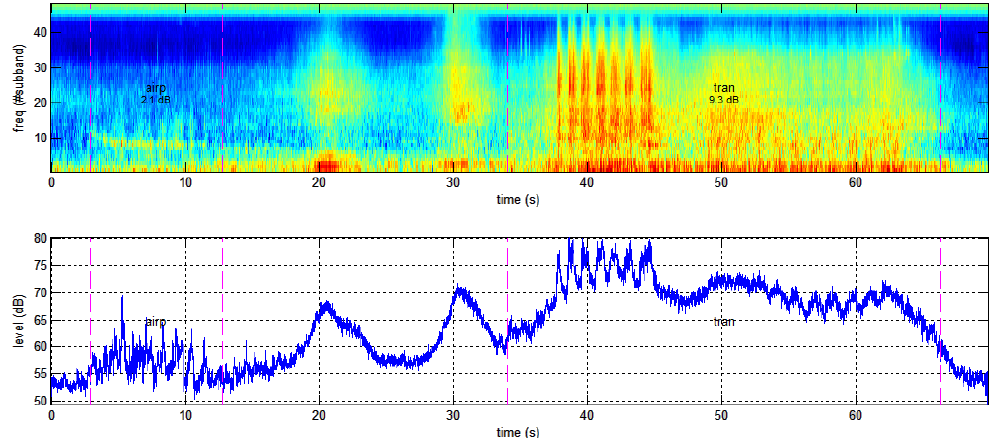
Figure A2. Examples of a mid-salient ANE (airplane, with SNR = 2.1 dB) and a highly-salient ANE (train, with SNR = 9.3 dB) in the urban scenario. Recordings were obtained in a one-way little road with very low traffic density and near a railway in Milan. GTCC-based spectrogram (upper) and A-weighted equivalent noise levels (bottom) are shown.